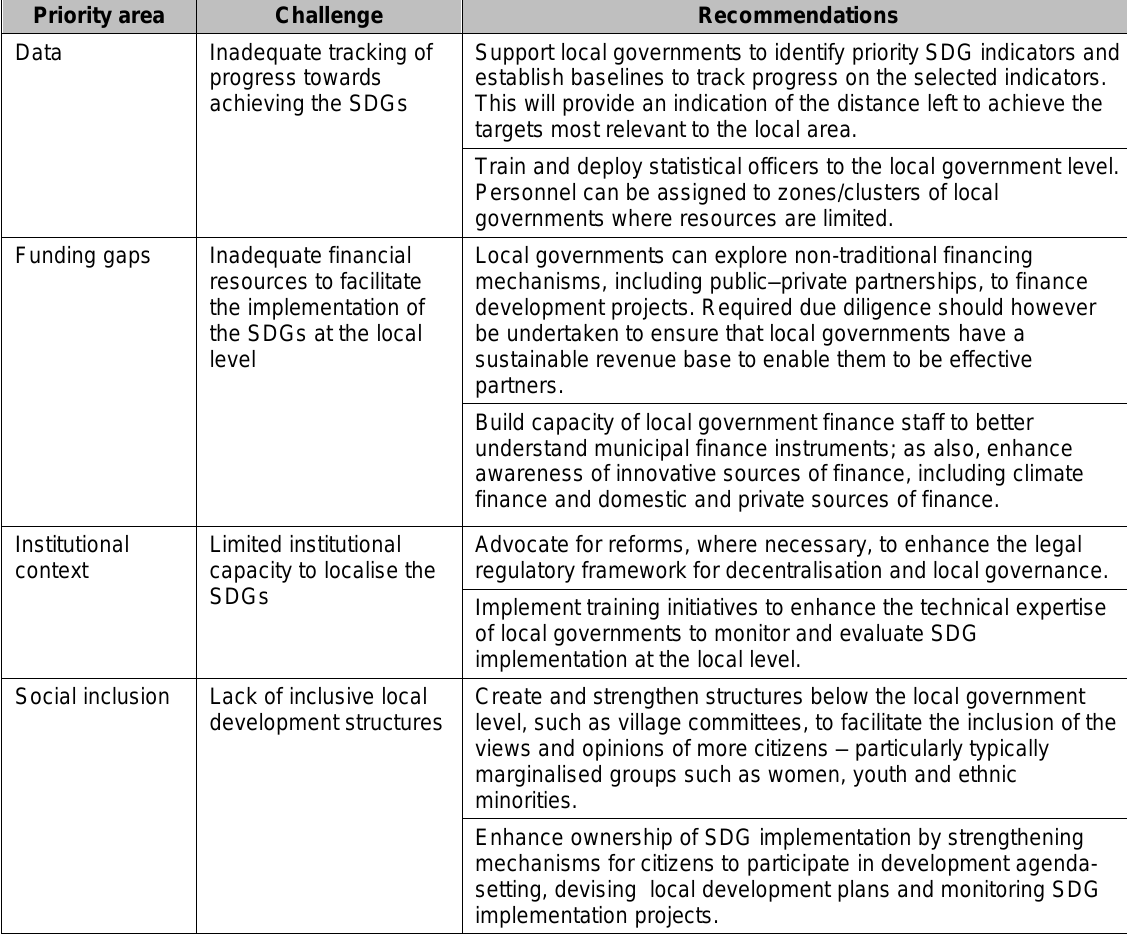
Table 4: Roadmap to address challenges of localising the SDGs in